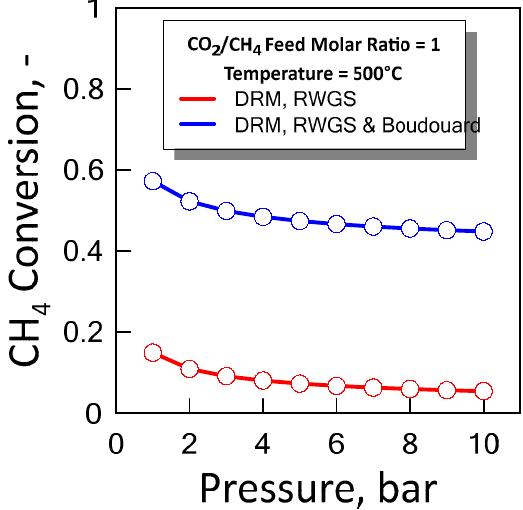
Figure 9. CH 4 equilibrium conversion at CO 2 /CH 4 feed molar ratio of 1 and temperature of 500 °C as a function of pressure.